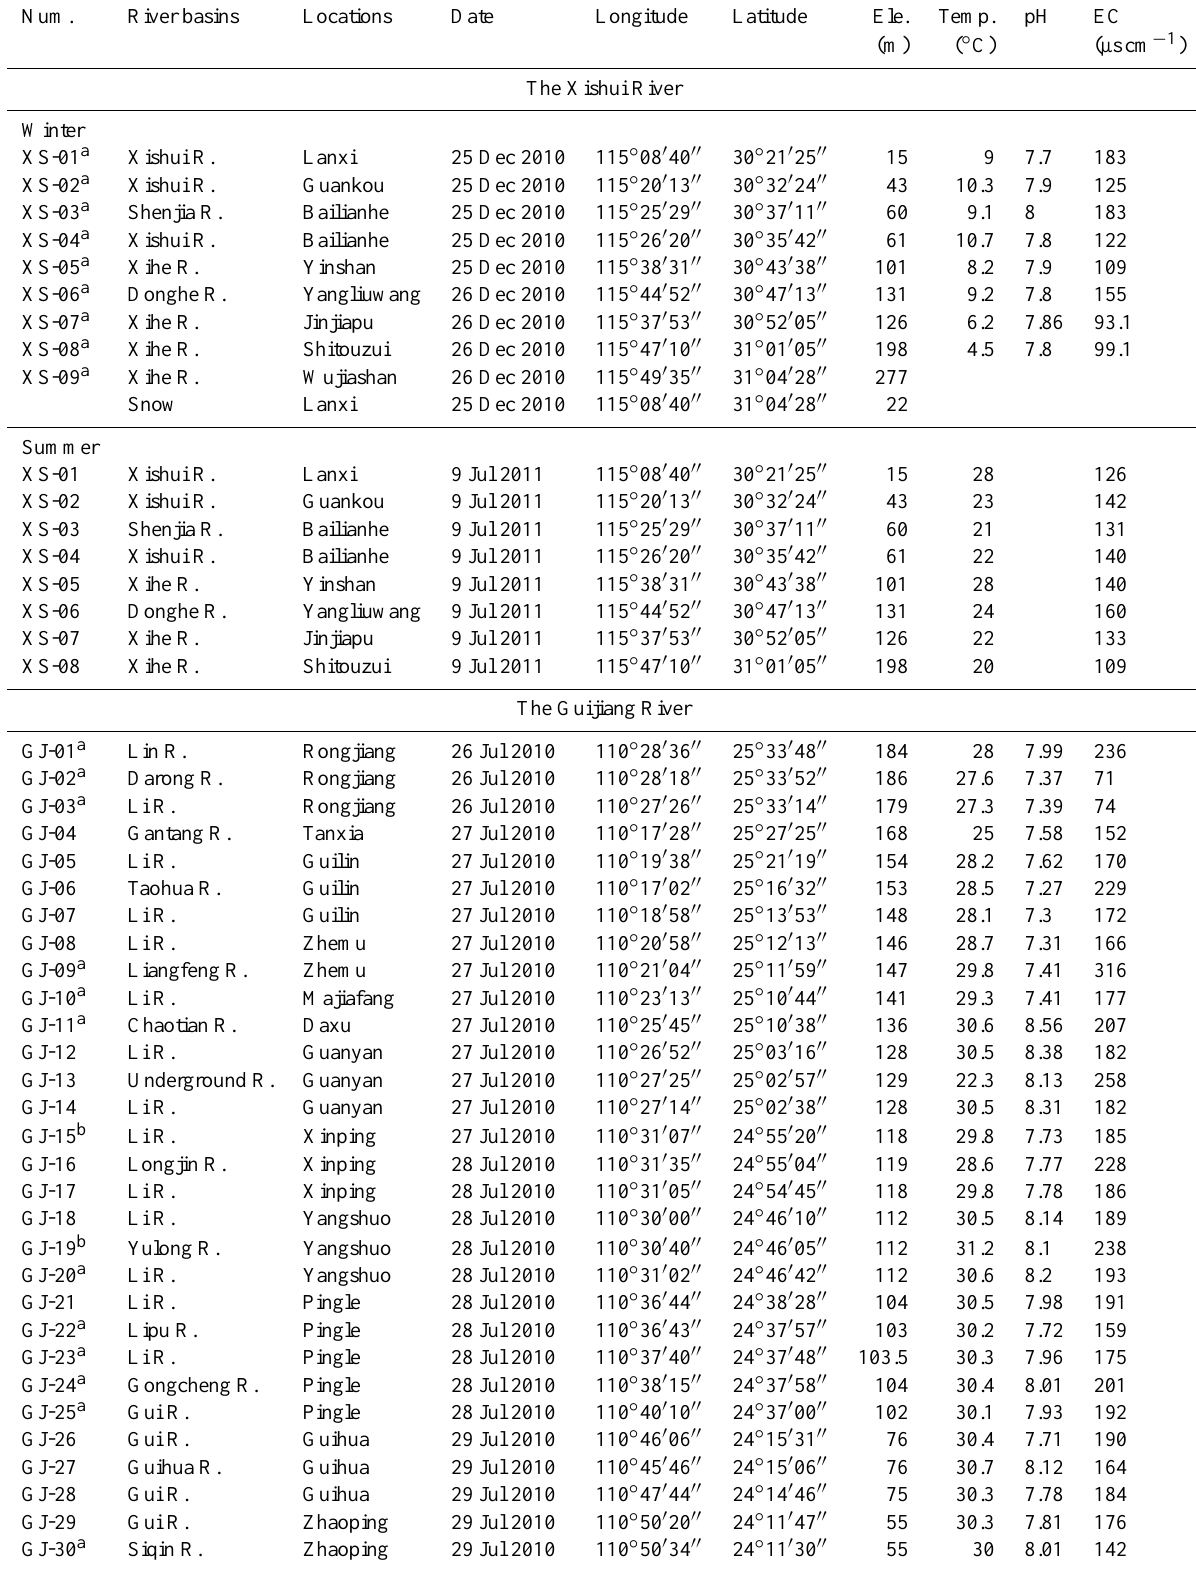
Table 1. The sampling information of the Xishui River and Guijiang River.